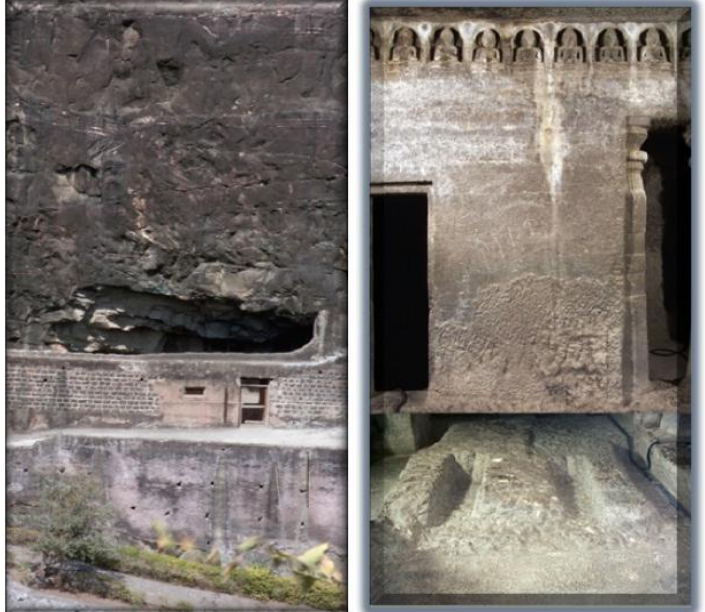
Figure 8. Cave 8 with weak rock causing problem to its stability and various excavators working on the same pillar of cave upper